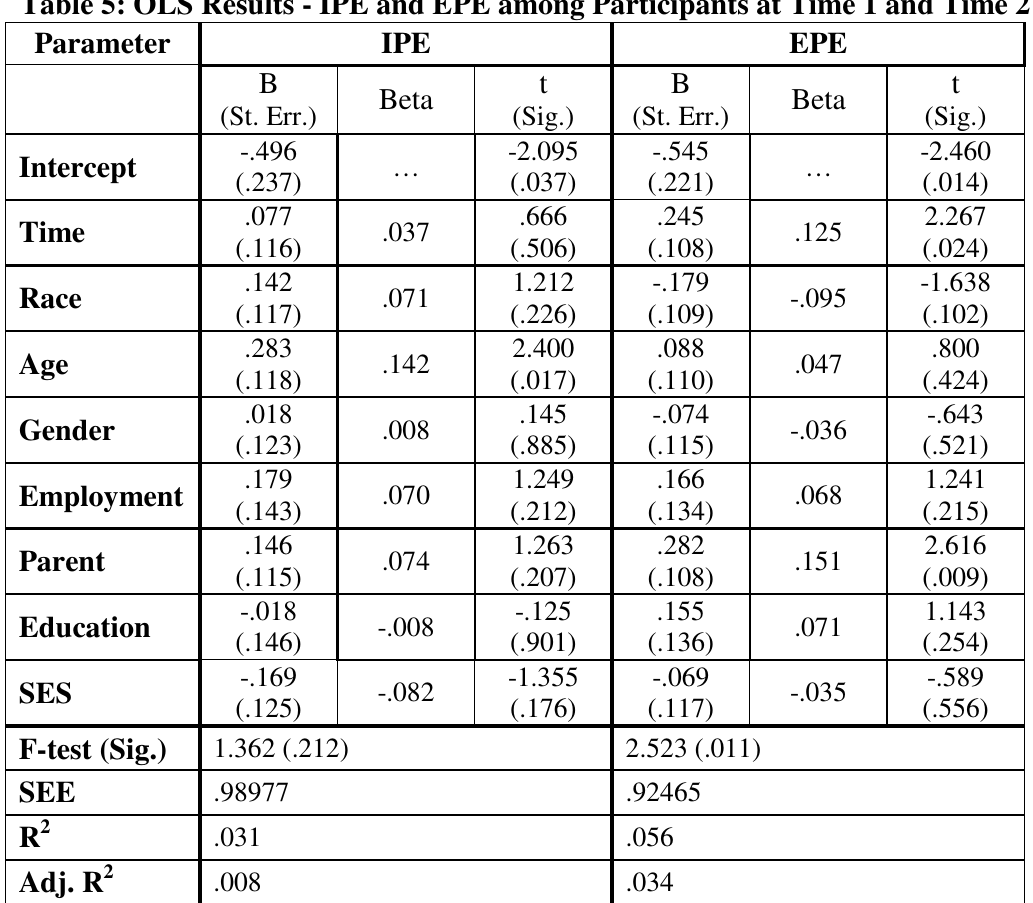
Table 5: OLS Results - IPE and EPE among Participants at Time 1 and Time